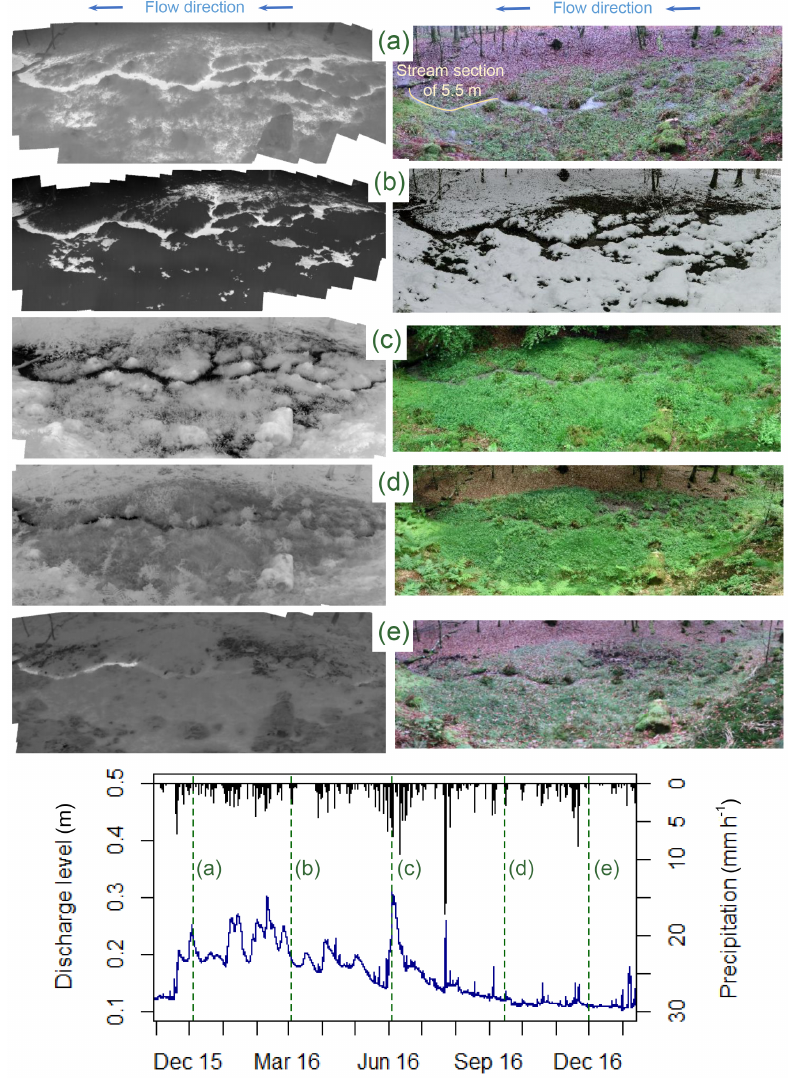
Figure 4. Time-lapse TIR and VIS panoramas, showing the variation of surface-saturation patterns with varying discharge levels under diverse seasonal